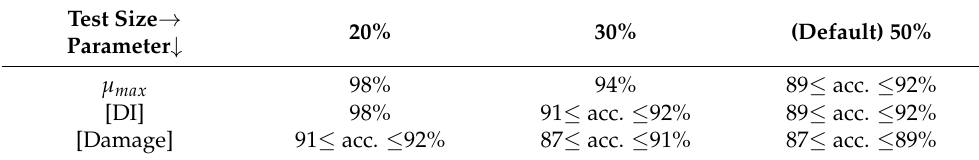
Table 5. Highest accuracies achieved in the supervised learning of the most-important parameters that efficiently estimate the outputs: the case when four direct inputs are used with